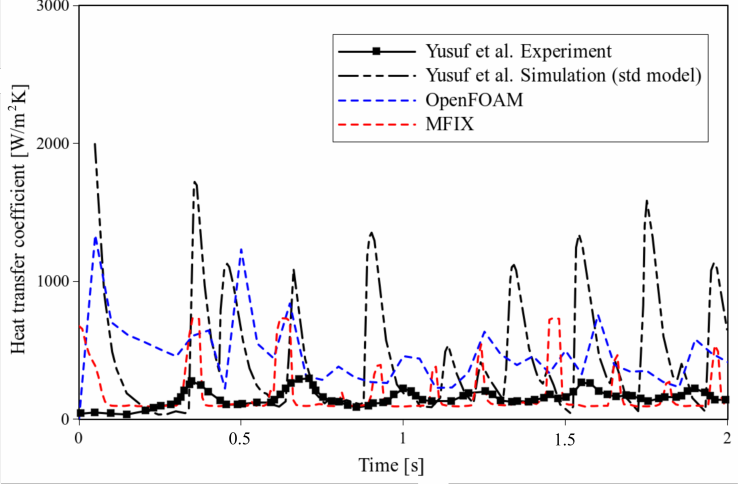
Figure 7. Heat transfer coefficient at y = 0.1165 m from the